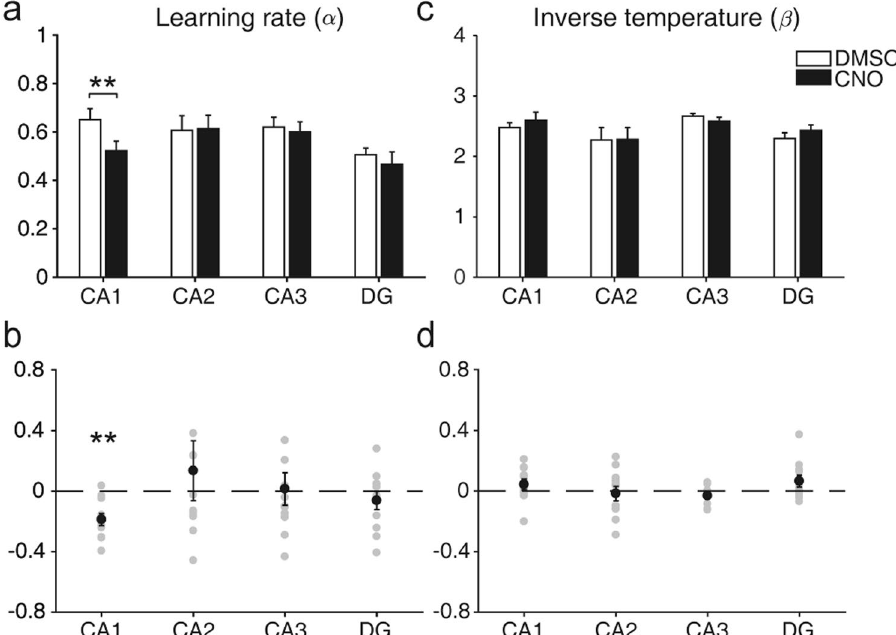
Figure 3. Effects of hippocampal subregional inactivation on learning rate and inverse temperature. ( a ) Learning rates ( α ) under DMSO and CNO conditions (mean ± SEM across animals). ( b ) Normalized change in learning rate (( α CNO − α DMSO )/ α DMSO ), shown for each animal (gray circles). The black circles and error bars denote mean and SEM across animals. ( c,d ) Inverse temperature ( β ). The same format as in ( a , b ). ** p < 0.01 (paired t